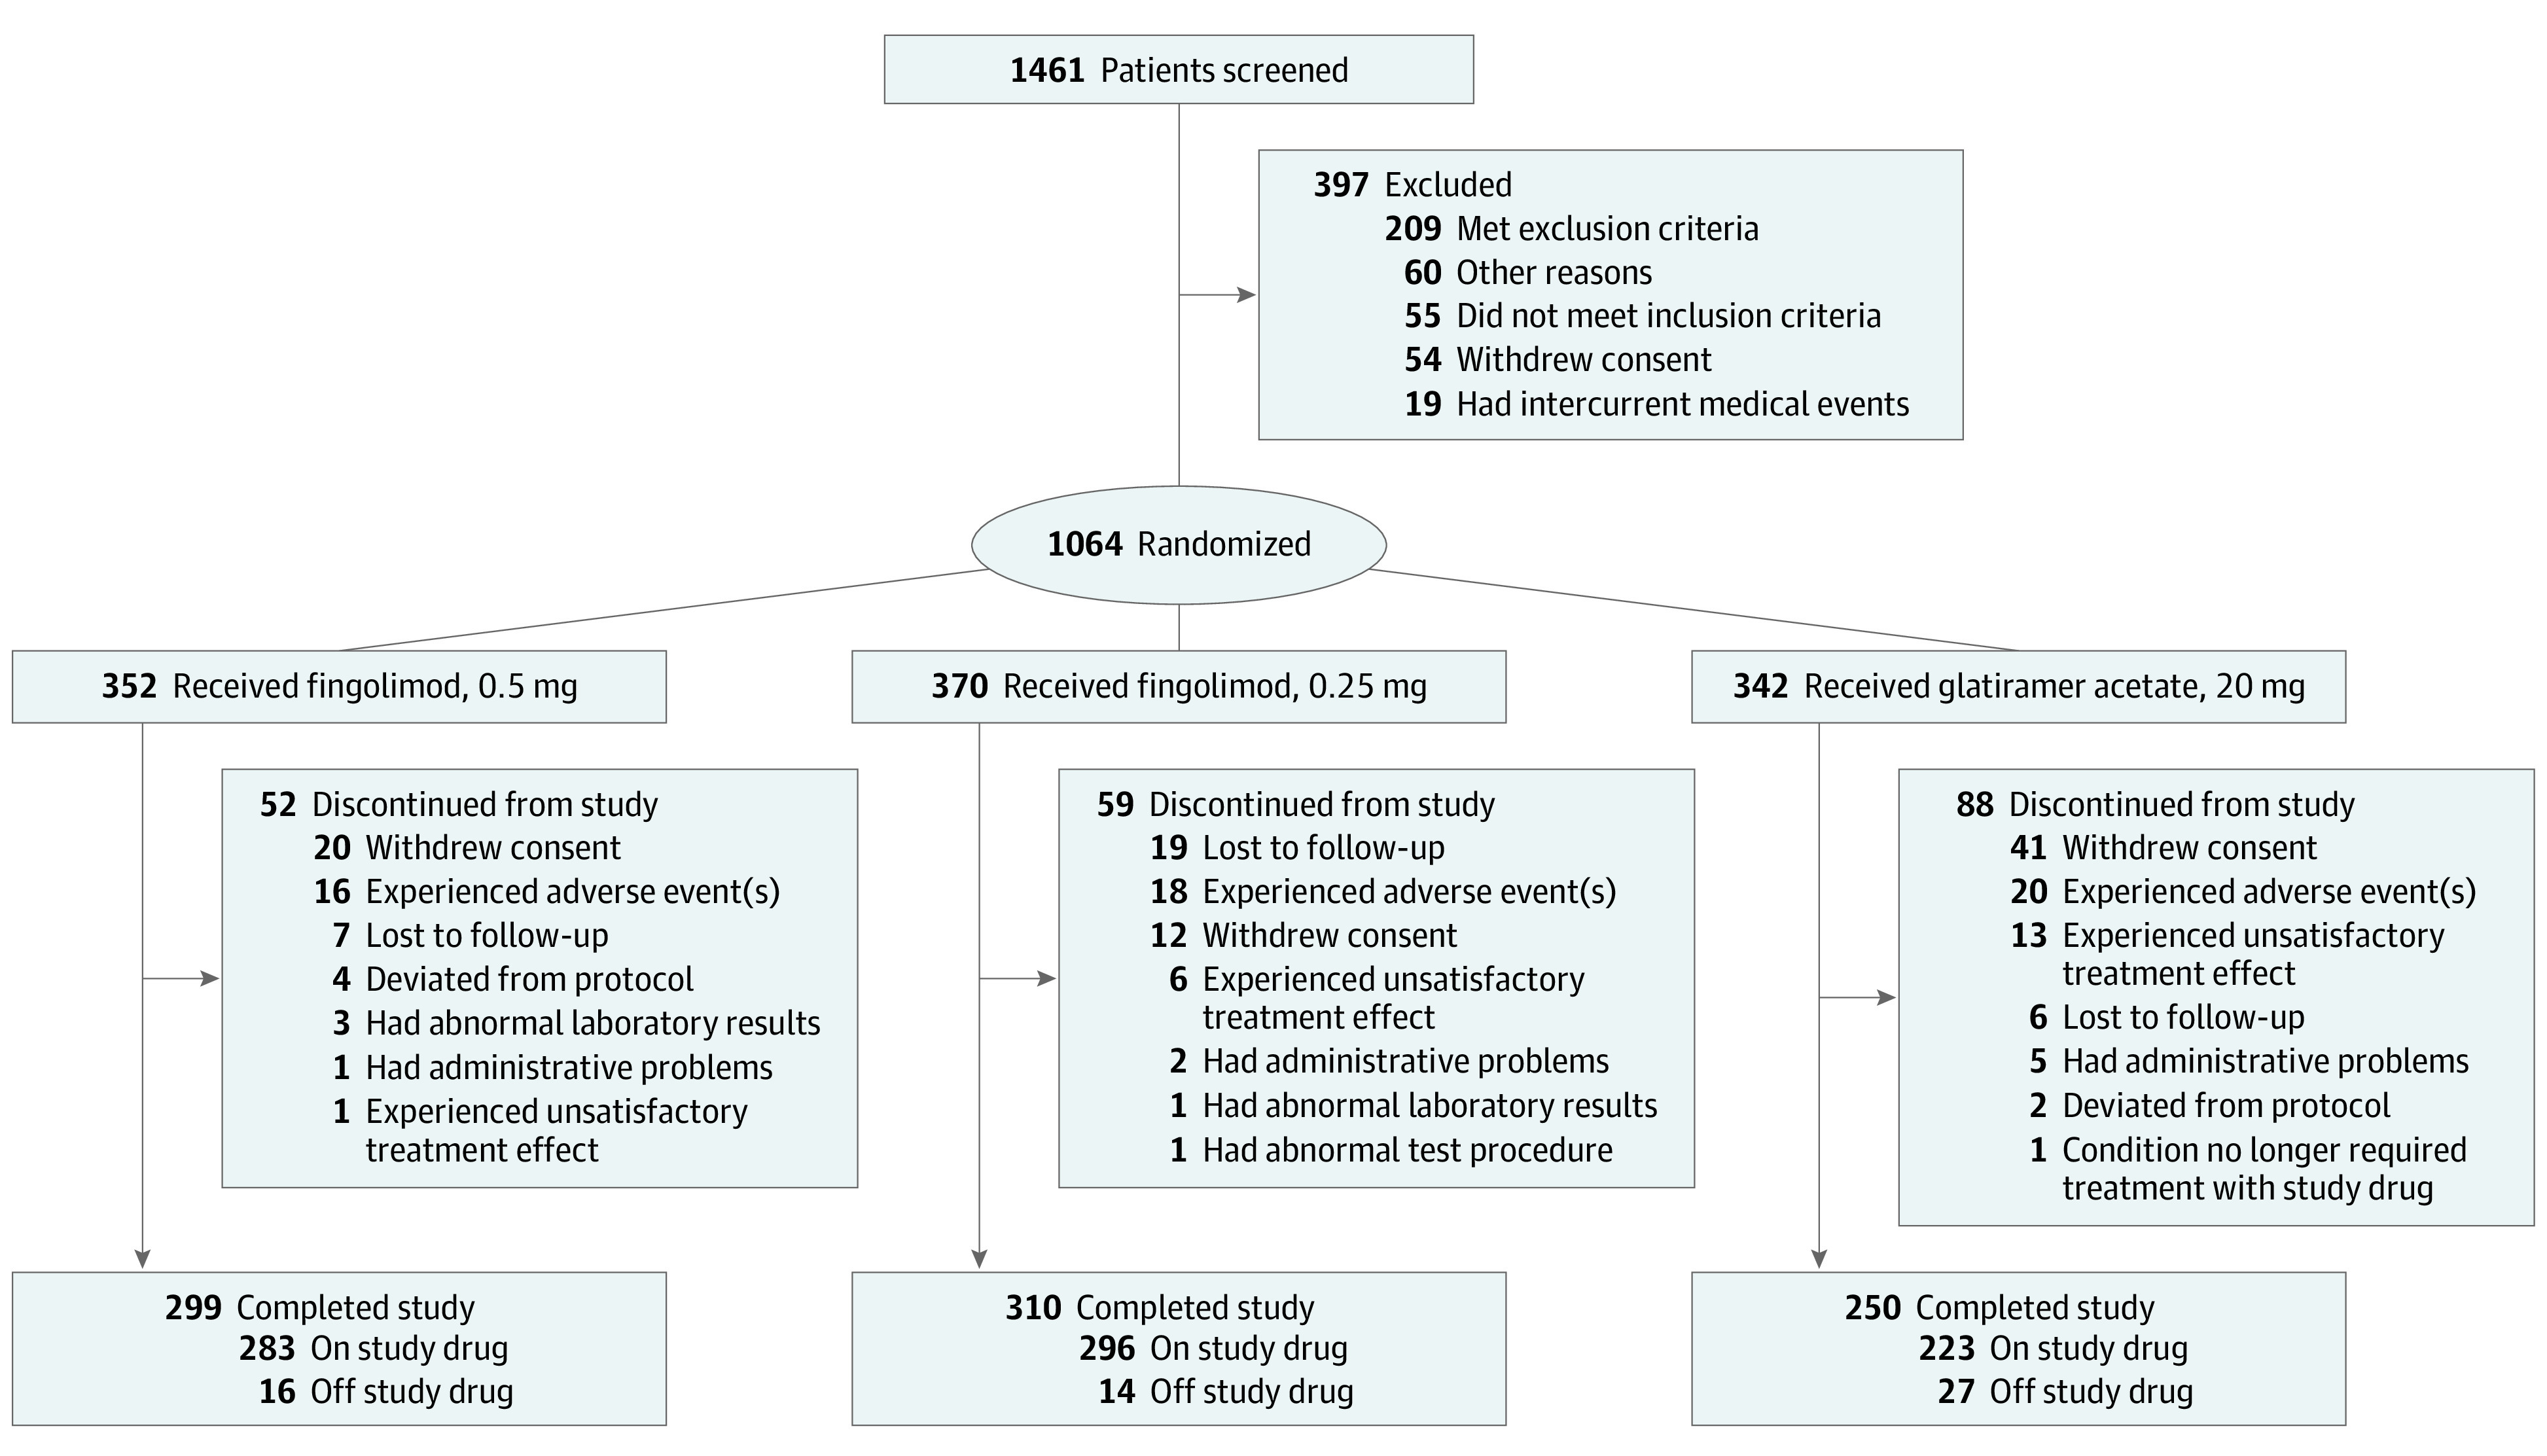
CONSORT DiagramA total of 2 participants from a closed site discontinued the study early, and 4 participants did not enter the treatment phase according to the screening log case report form. These 6 participants were not considered to be discontinued from the study because they were missing study completion case report forms. Off study drug indicates participants who completed the study but discontinued treatment with the study drug prematurely. On study drug indicates participants who received treatment with the study drug until study completion.